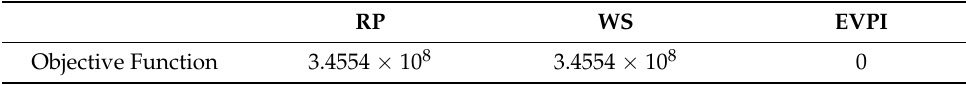
Table 4. Values of objective function due to RP, WS, and EVPI.